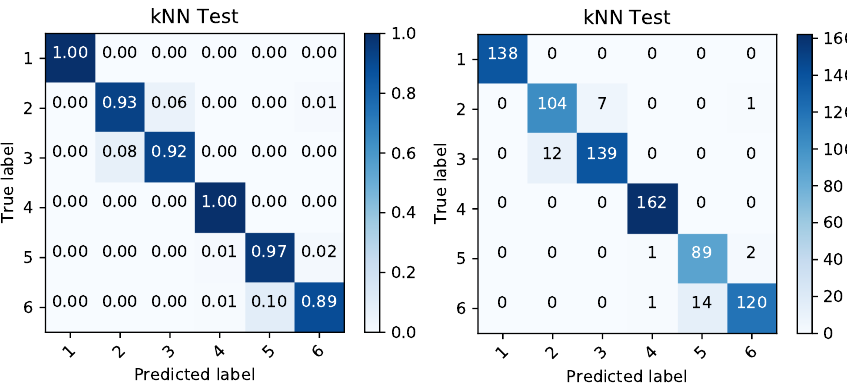
Figure 13. Confusion matrices produced by k nearest neighbor (kNN) prediction based on voltage data during charging period. The matrix of percentages between correctly and incorrectly classified samples ( left ) is accompanied by a confusion matrix covering the absolute values of the same classified samples ( right ).